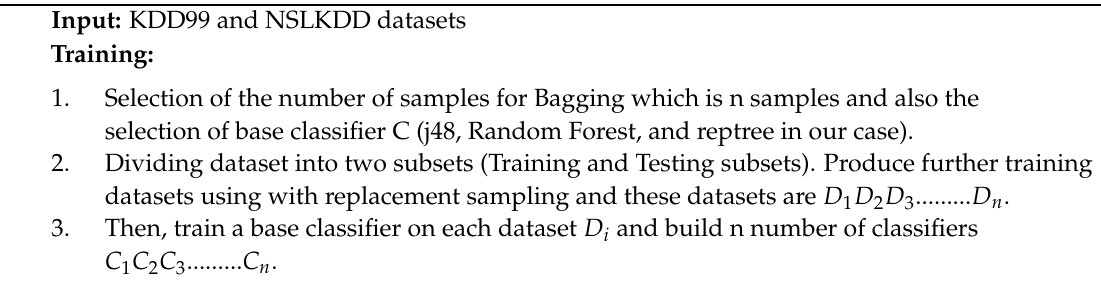
Algorithm 2: Bagging classifier